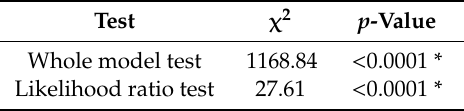
Table 2. Model performance chi-squared values.